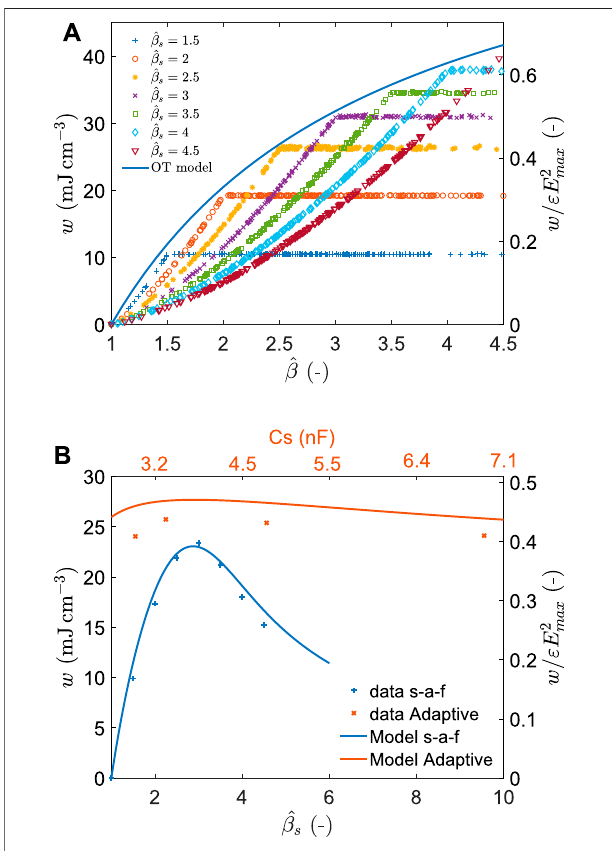
FIGURE10|(A) Energydensity(left axis)and normalisedenergy density (rightaxis) obtained using the set-and-forget scheme for different values of (cid:10) β s , and 200 cycles for each value, randomly chosen with a normal distribution with μ = 2.75, and σ = 0.8. (B) Average energy density (left axis) and normalised energy density (right axis) per cycle calculated on 200 cycles followinganormal distribution with μ = 2.75,and σ =0.8. Blueisusingtheset- and-forget approach, and red is using the adaptive harvesting cycle approach.Theupper x axisindicatethevalueof C s correspondingto (cid:10) β s forthe Adaptive